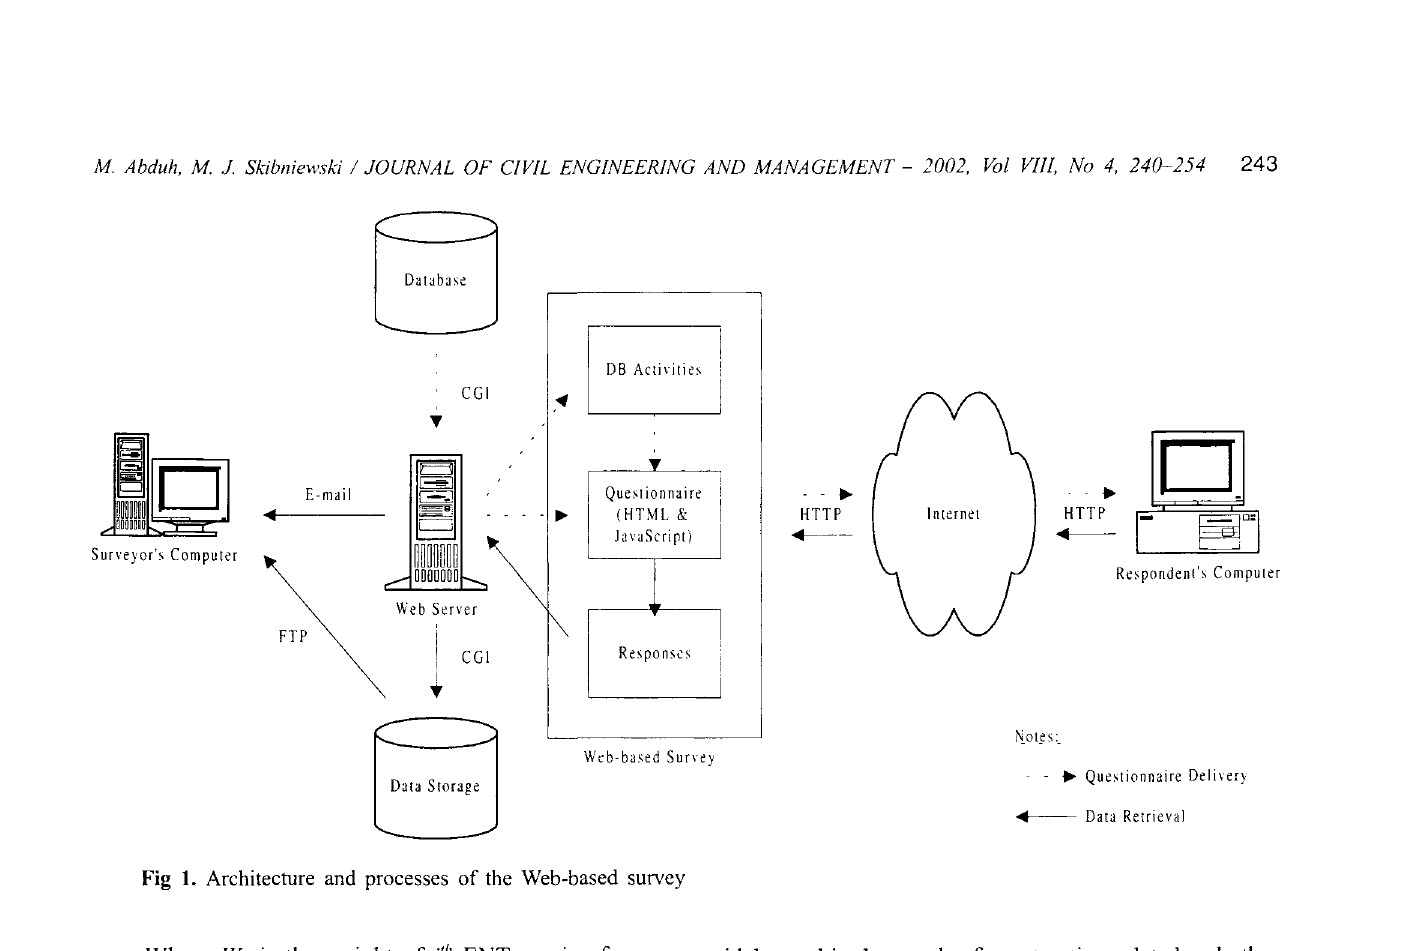
Where W is the weight of i 1 " ENT service for ac tivity j, whichlfcan be assessed by comparing the activi ties with respect to their overall value adding contribu tion to the